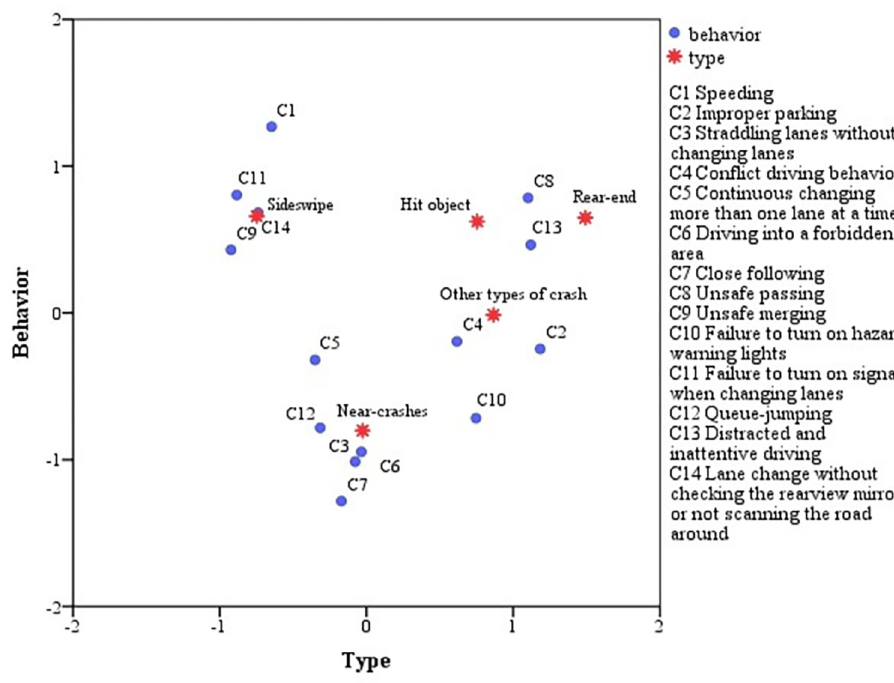
Fig 1. Corresponding analysis of unsafe behaviors for different types of crashes.